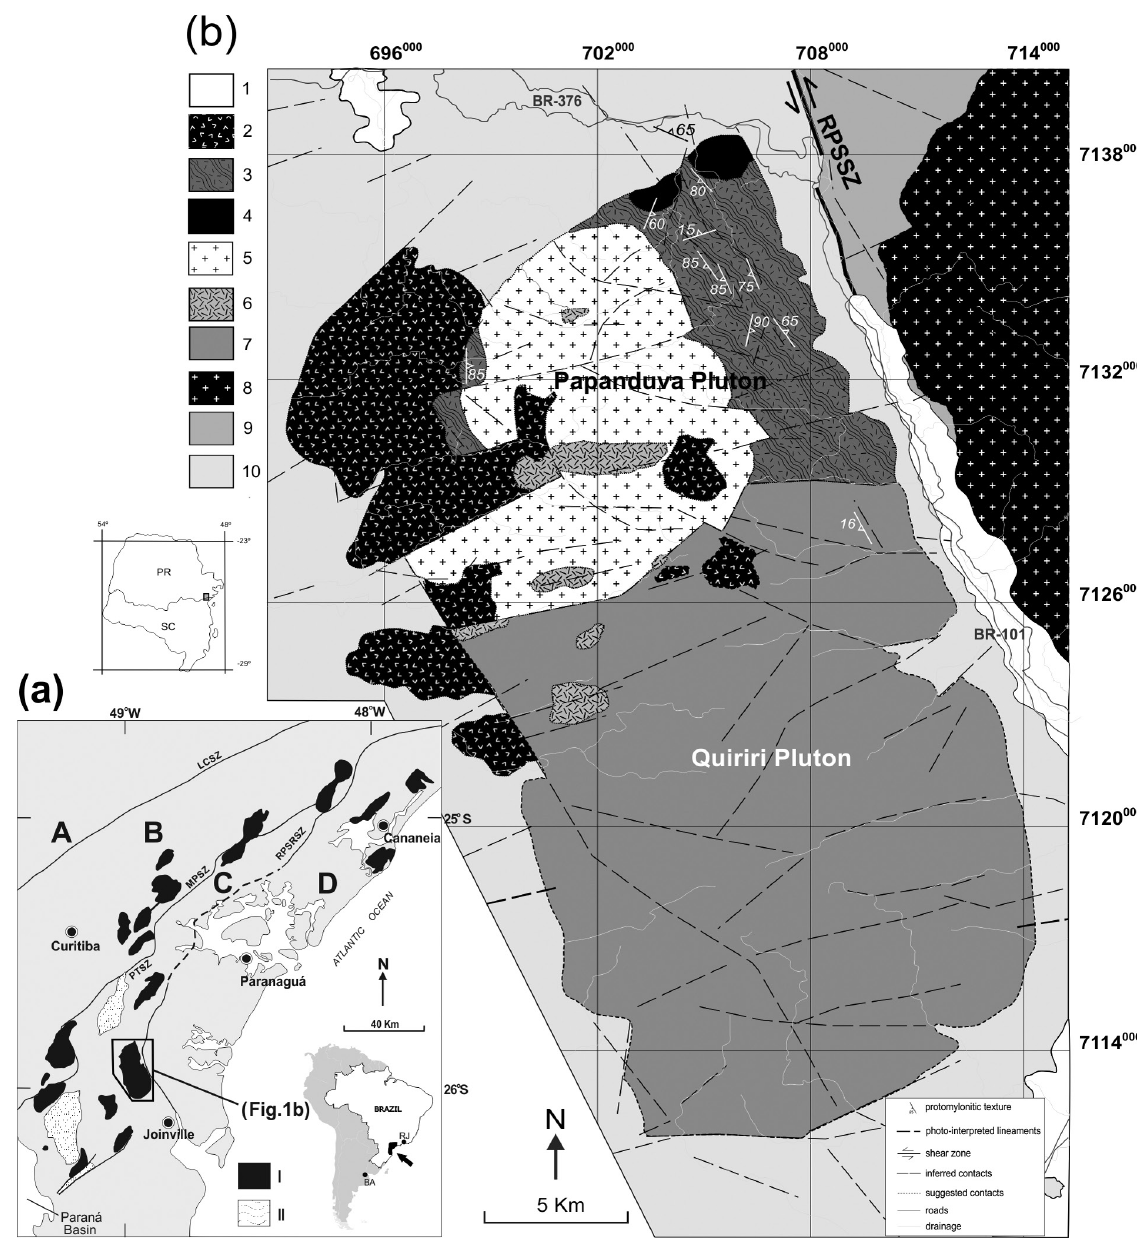
Figure 1 - Geological context of the Morro Redondo Complex. (a) Geological sketch of the Neoproterozoic A-type Graciosa Province (I) showing the location of the Morro Redondo Complex, as well as contemporaneous volcanosedimentary basins (II) in southern Brazil and the positioning in the South America Continent (RJ = Rio de Janeiro, BA = Buenos Aires, Argentina). Main regional tectonic units are: A – Ribeira Fold Belt, B – Curitiba Microplate, C – Luiz Alves Microplate (Craton), D – Paranaguá Terrain (Coastal Granitoid Belt). Adapted from Prazeres Filho et al. (2003) and Gualda and Vlach (2007a). (b) Geological map of the Morro Redondo Complex and surrounding areas. (1) alluvial-colluvial deposits, (2) contemporaneous bimodal volcanic rocks, (3 to 6) peralkaline alkali-feldspar granites from the Papanduva Pluton: (3) protomylonitic facies, (4) cataclastic facies, (5) massive facies, (6) microgranitic facies; (7) peraluminous biotite sieno - and monzogranites from the Quiriri Pluton, (8) Estrela high-K calc-alkaline granite and (9) metasedimentary rocks of the Paranaguá Terrain; (10) gneiss, granulites and migmatites of the Luiz Alves Microplate. Adapted from Vilalva